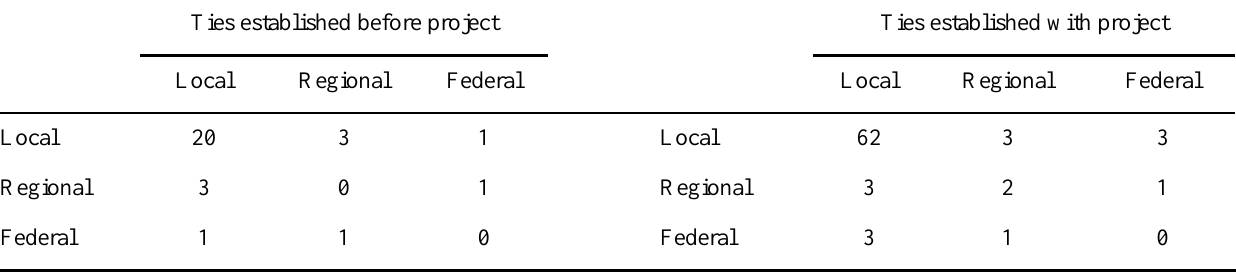
Table 2. Tie strengths between administrative levels, Binntal (close collaboration). Ties established before project Ties established with